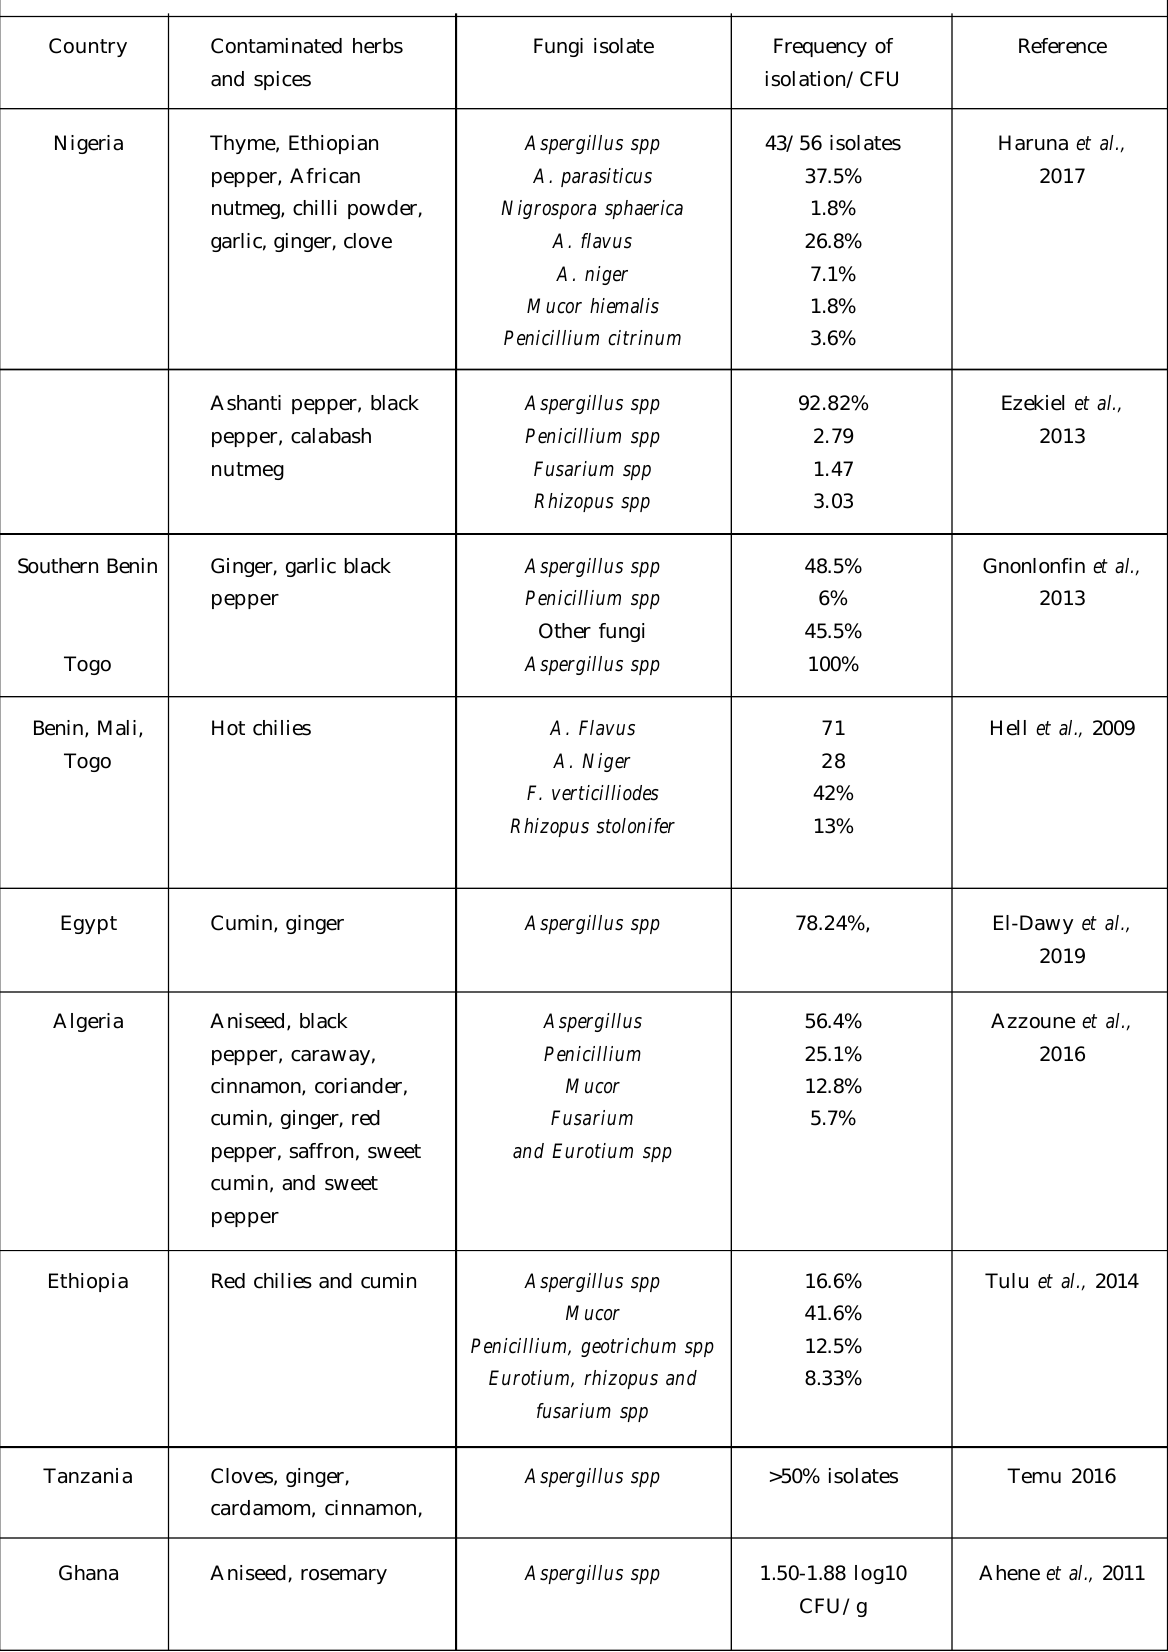
Table 1: Frequency of fungal isolation from culinary herbs and spices in Africa